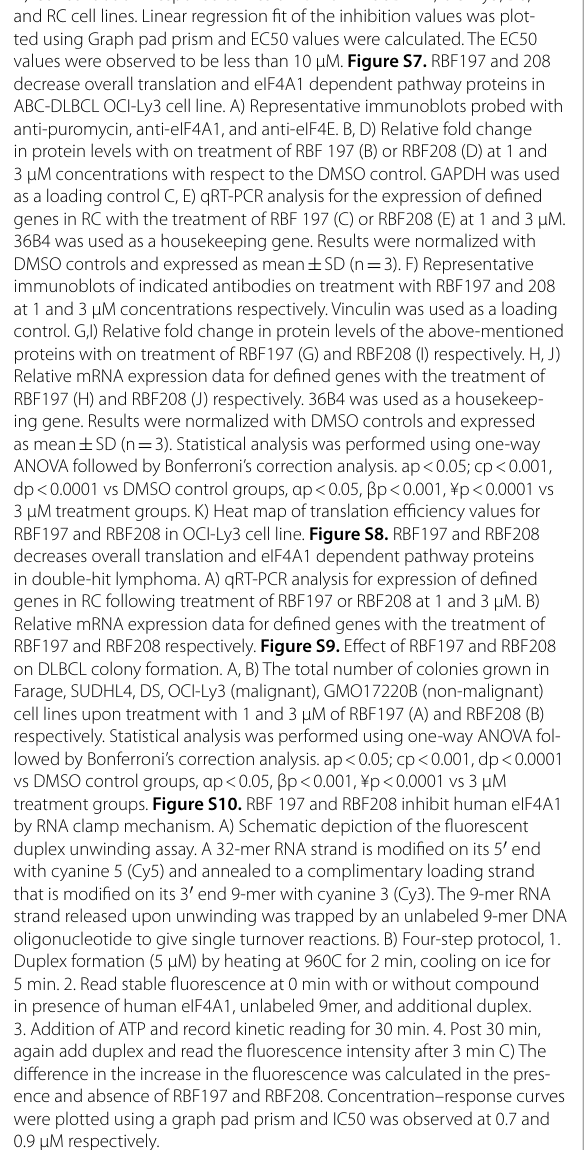
Additional file 2: Supplemental Table 1. Sequence of the primers and probes used. Supplemental Table 2. Compounds screened, their corresponding Molport ID and IUPAC names (screen 1). Supplemental Table 3. Compounds screened, their corresponding Molport ID and IUPAC names (screen 2). Supplemental Table 4. IC50 values of selected RBFs compound in a panel of five DLBCL cell lines using WST-1